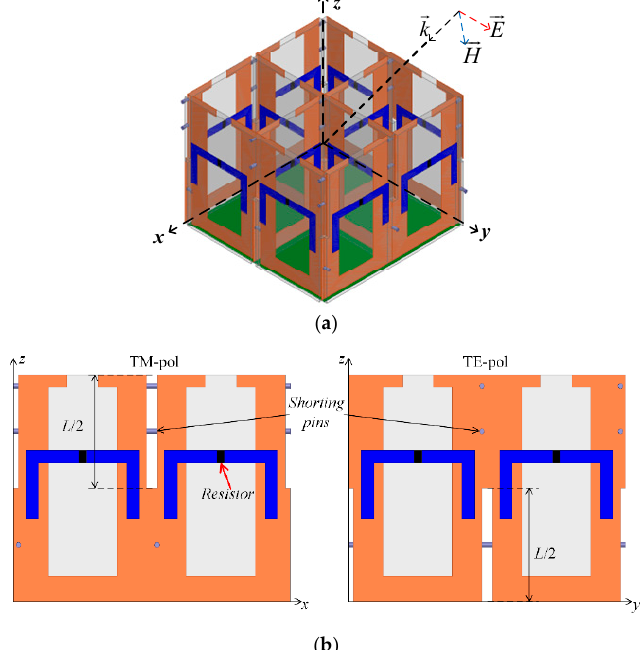
Figure 6. Structure of the proposed dual-polarized absorber: ( a ) 3D view (2×2 unit cells); ( b ) 2D view of two unit cells for TM and TE